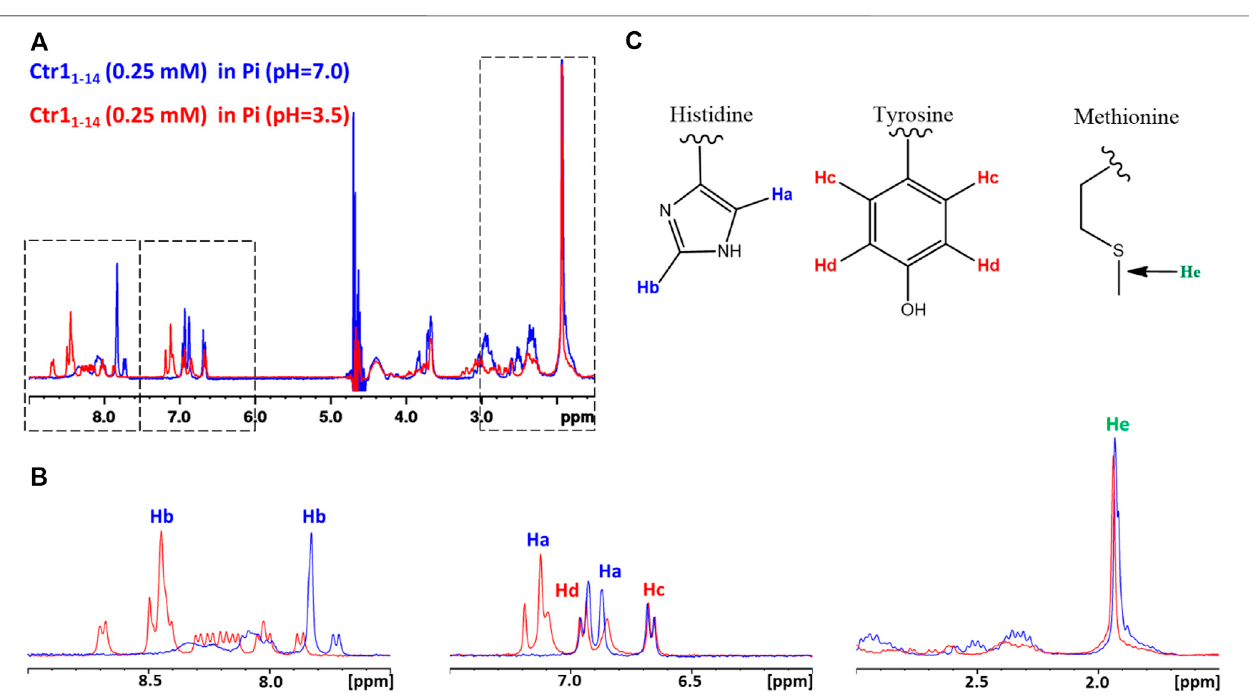
FIGURE 1 | (A) Superposition of 1D 1 H NMR spectra of Ctr1 1-14 in 25 mM Pi buffer at pH 7.0 ( blue contours ) and 3.5 ( red contours ). The regions enclosed in dashed boxes are expanded in (B) . The proton assignment scheme is shown in (C) where the structure of aminoacid side chains is